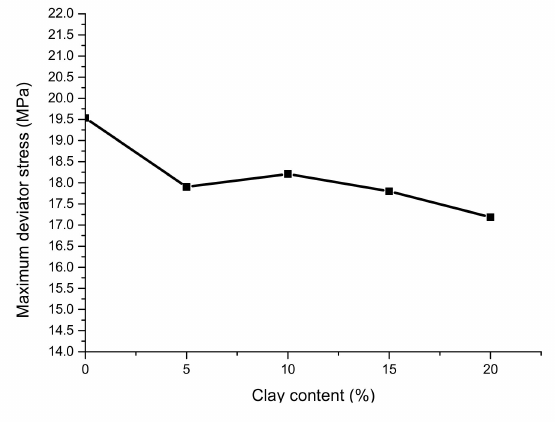
Figure 4. Maximum deviator stress by clay content